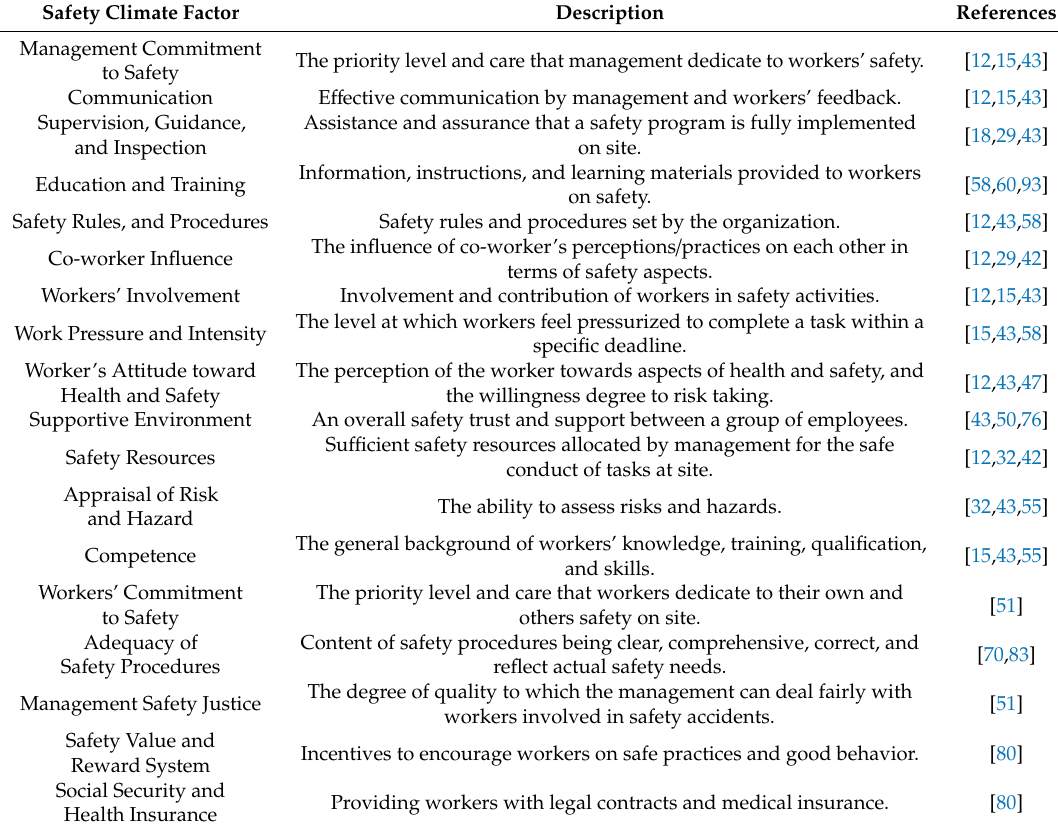
Table 3. Description of safety climate